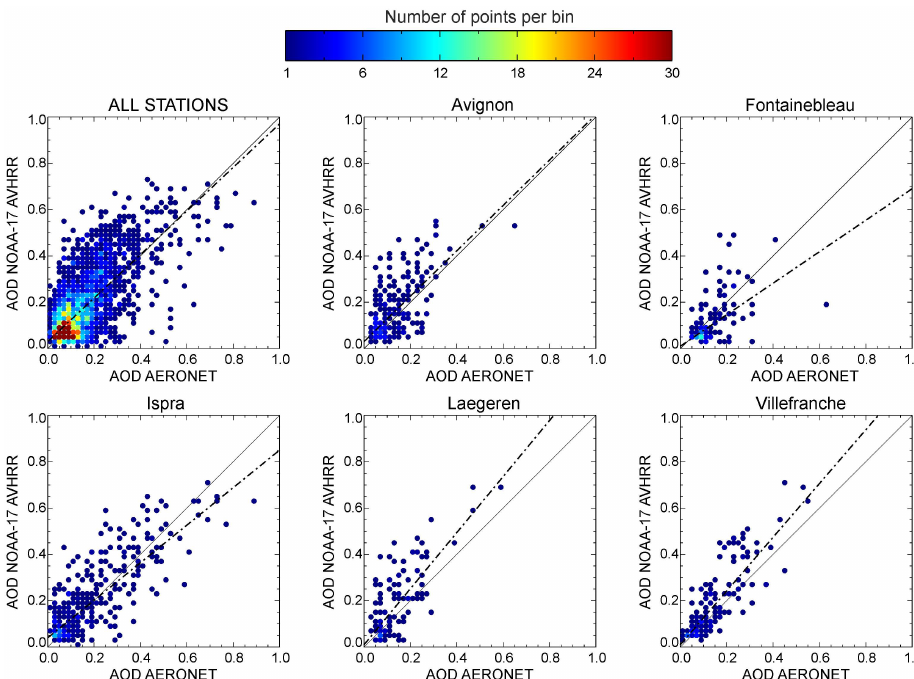
Fig. 3. Scatter-density plots for NOAA-17 AVHRR using the summary of all AERONET sites and five exemplary locations. For the density plot the point to point comparisons were binned into boxes of 0.02 × 0.02 and were assigned to the center of the box, while the statistics are based on the point to point comparison. In addition, the 1:1 intersection line (solid) and the linear regression lines (dash-dotted) are shown. Detailed statistical results are displayed in Table 3.